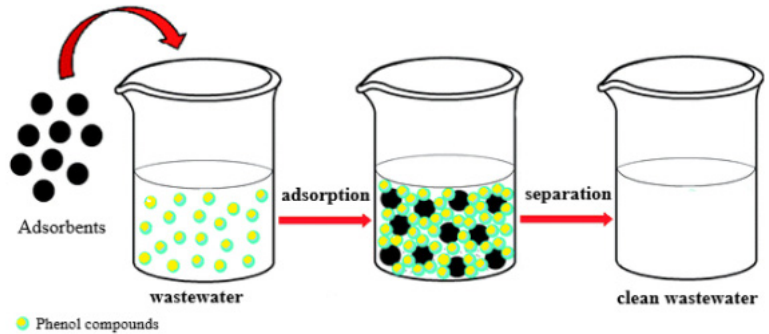
Figure 7. Schematic of phenol removal from wastewater in batch system adsorption.